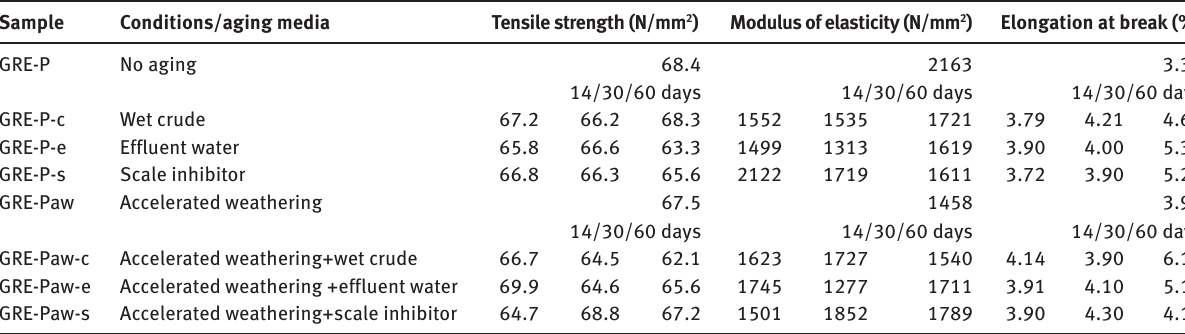
Table 3: Tensile analysis of GRE-P and GRE-Paw at various chemical aging conditions.